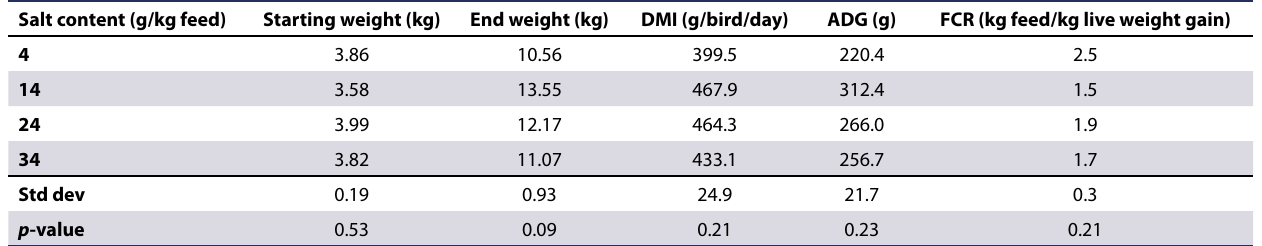
Table V: The effect of dietary salt inclusion on production performance of ostrich chicks 7–12 weeks of age Salt content (g/kg feed)